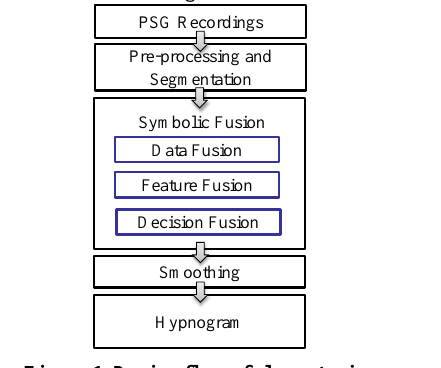
Figure 1. Design flow of sleep staging